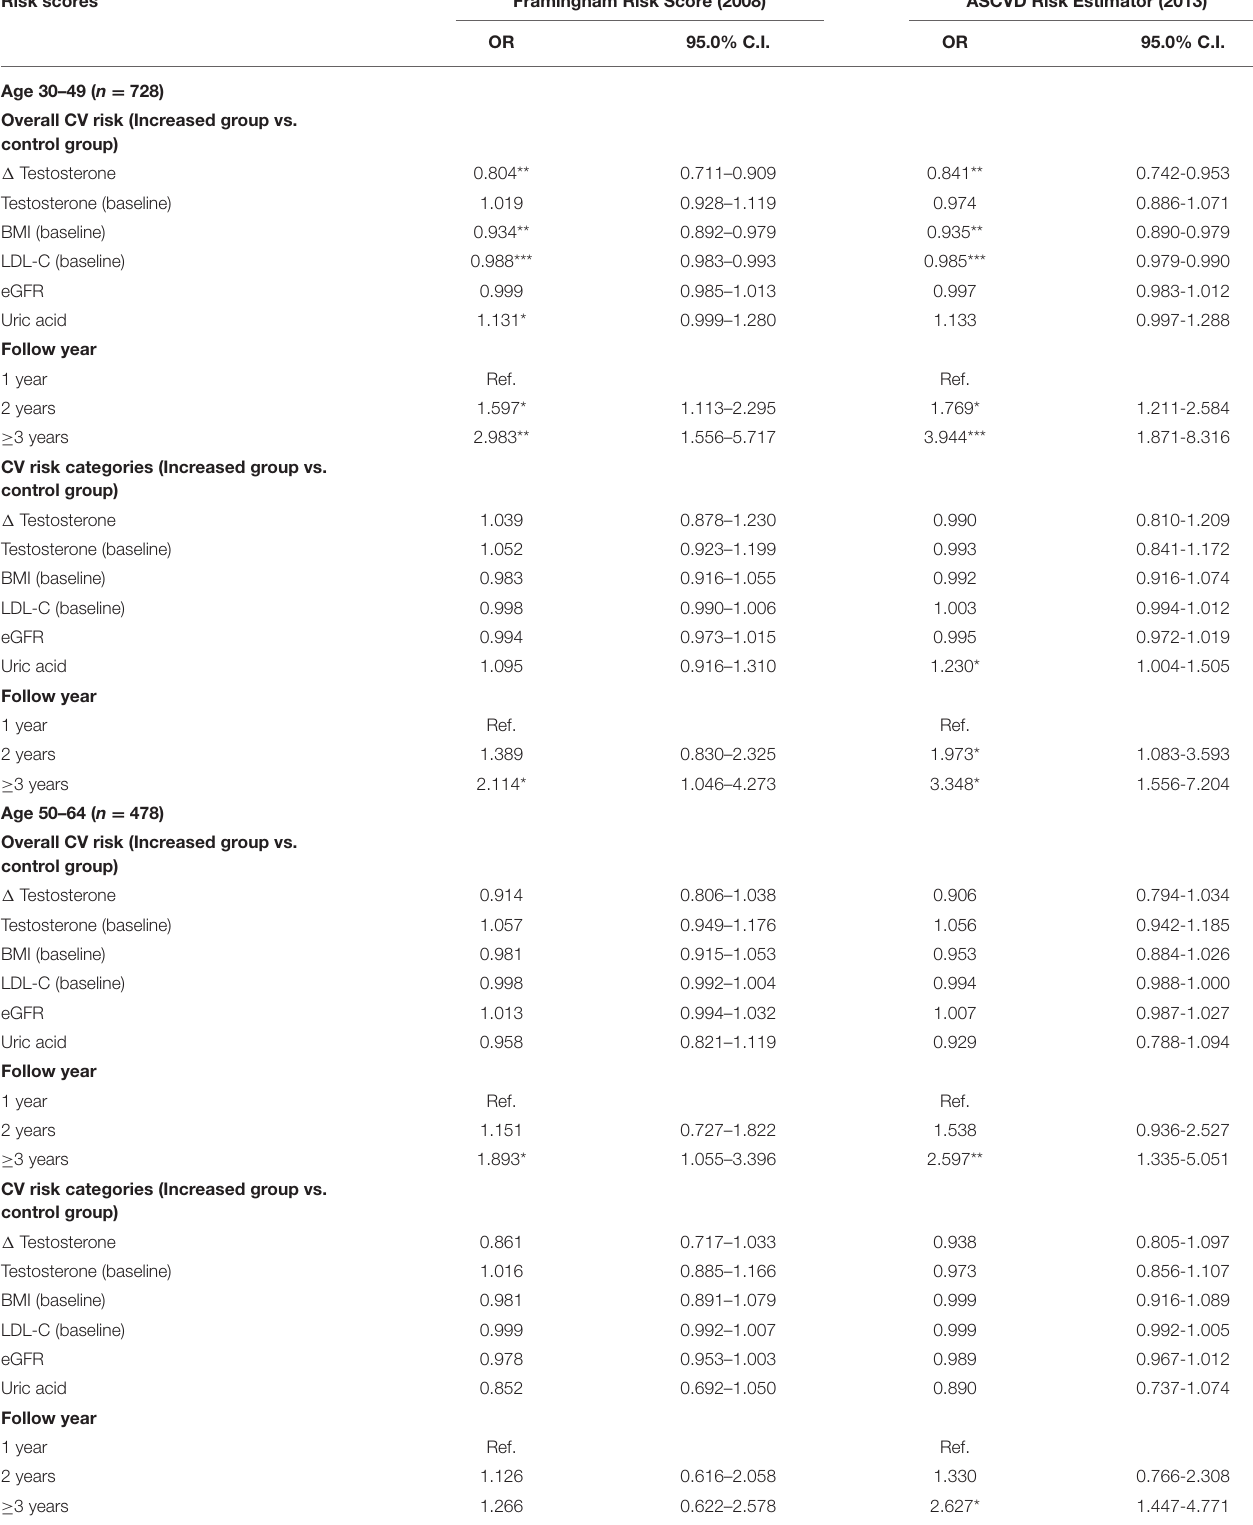
TABLE 2 | Logistic regression analysis of correlations between the increase in cardiovascular risk assessed and selected